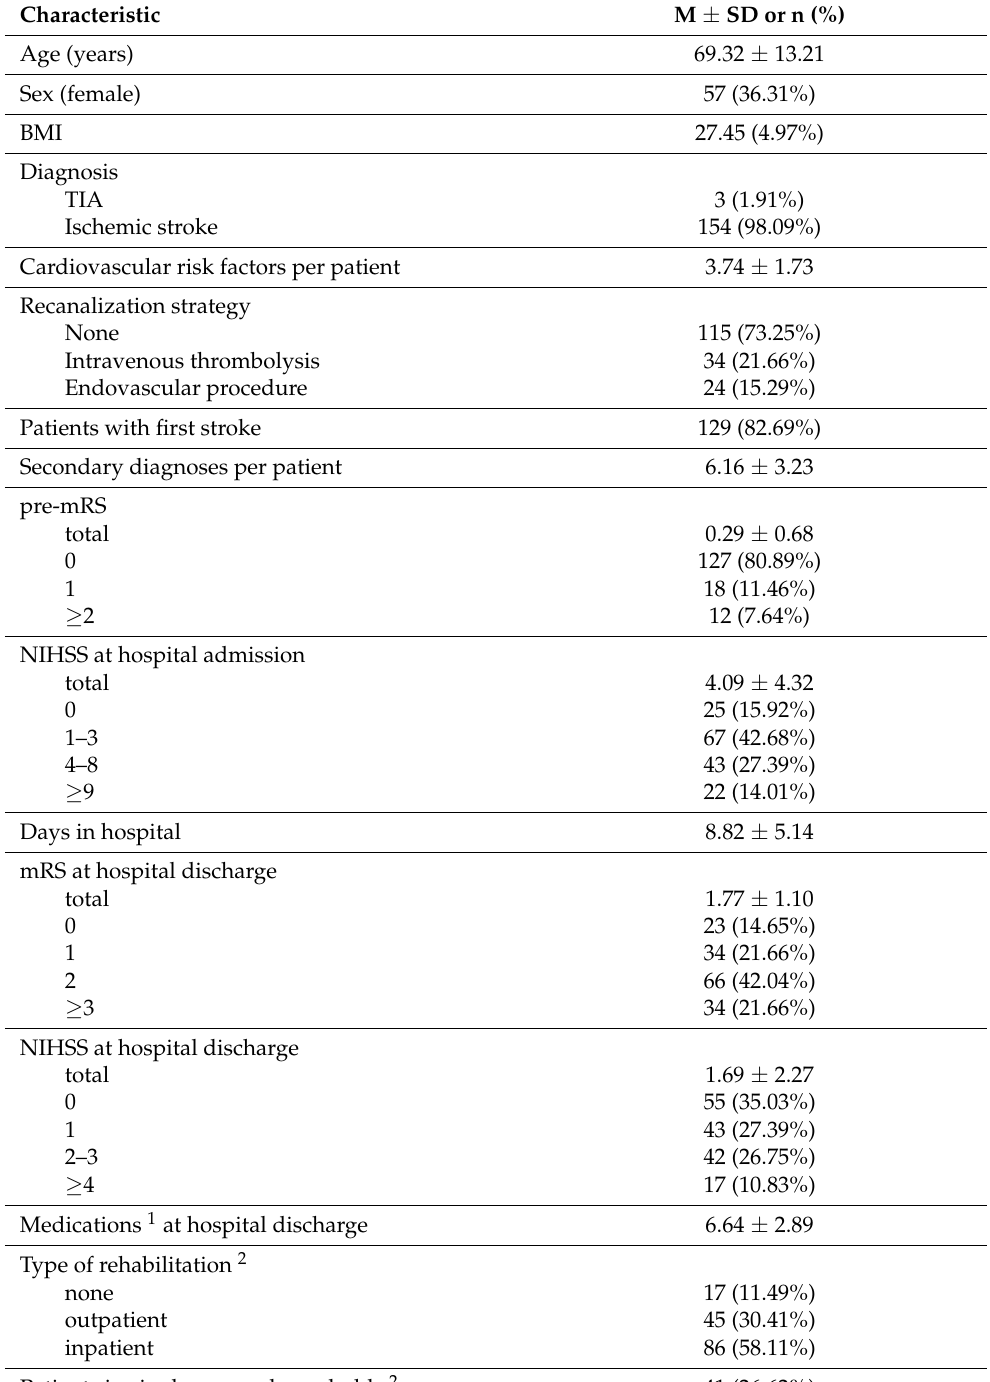
Table 1. Baseline characteristics of patients contacted by